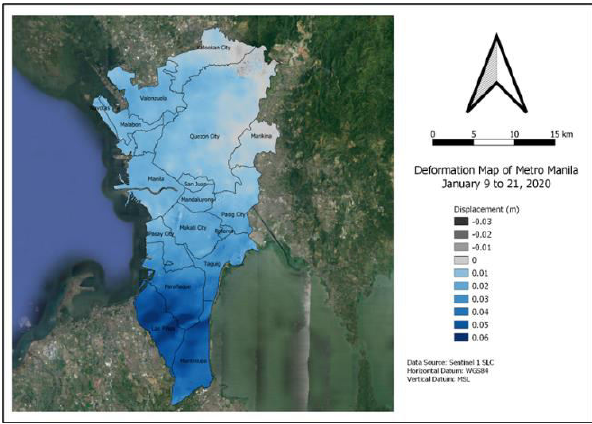
Figure 12. LOS Deformation